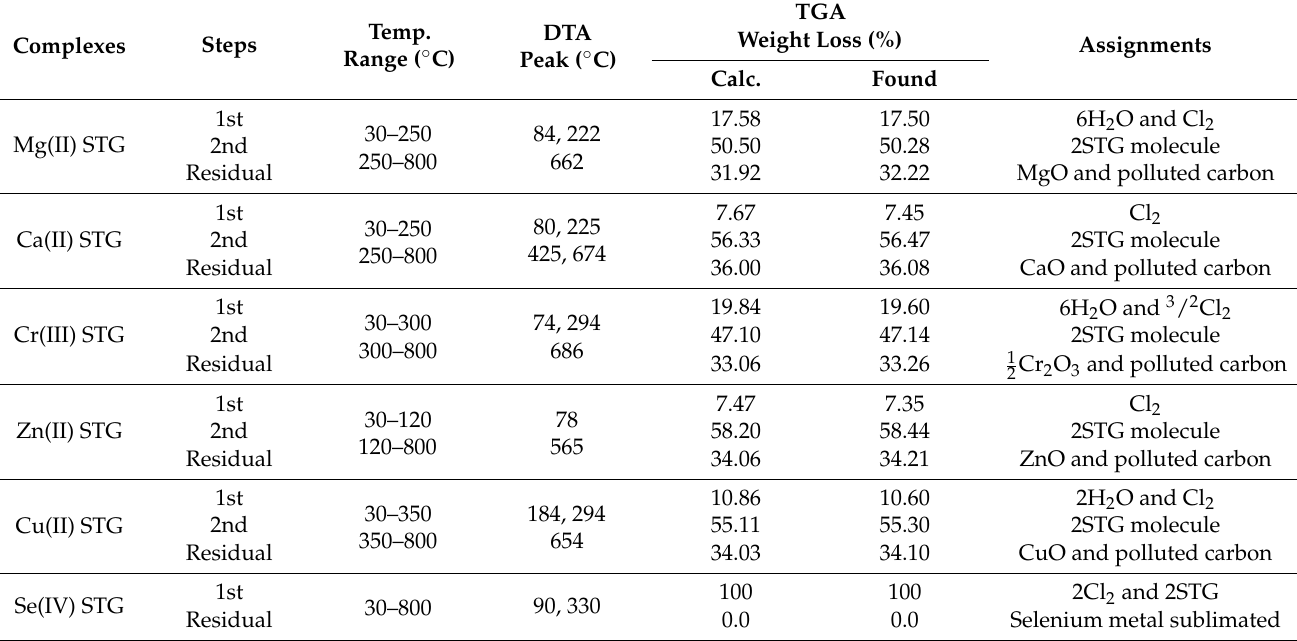
Table 3. Thermal data of the STG complexes.